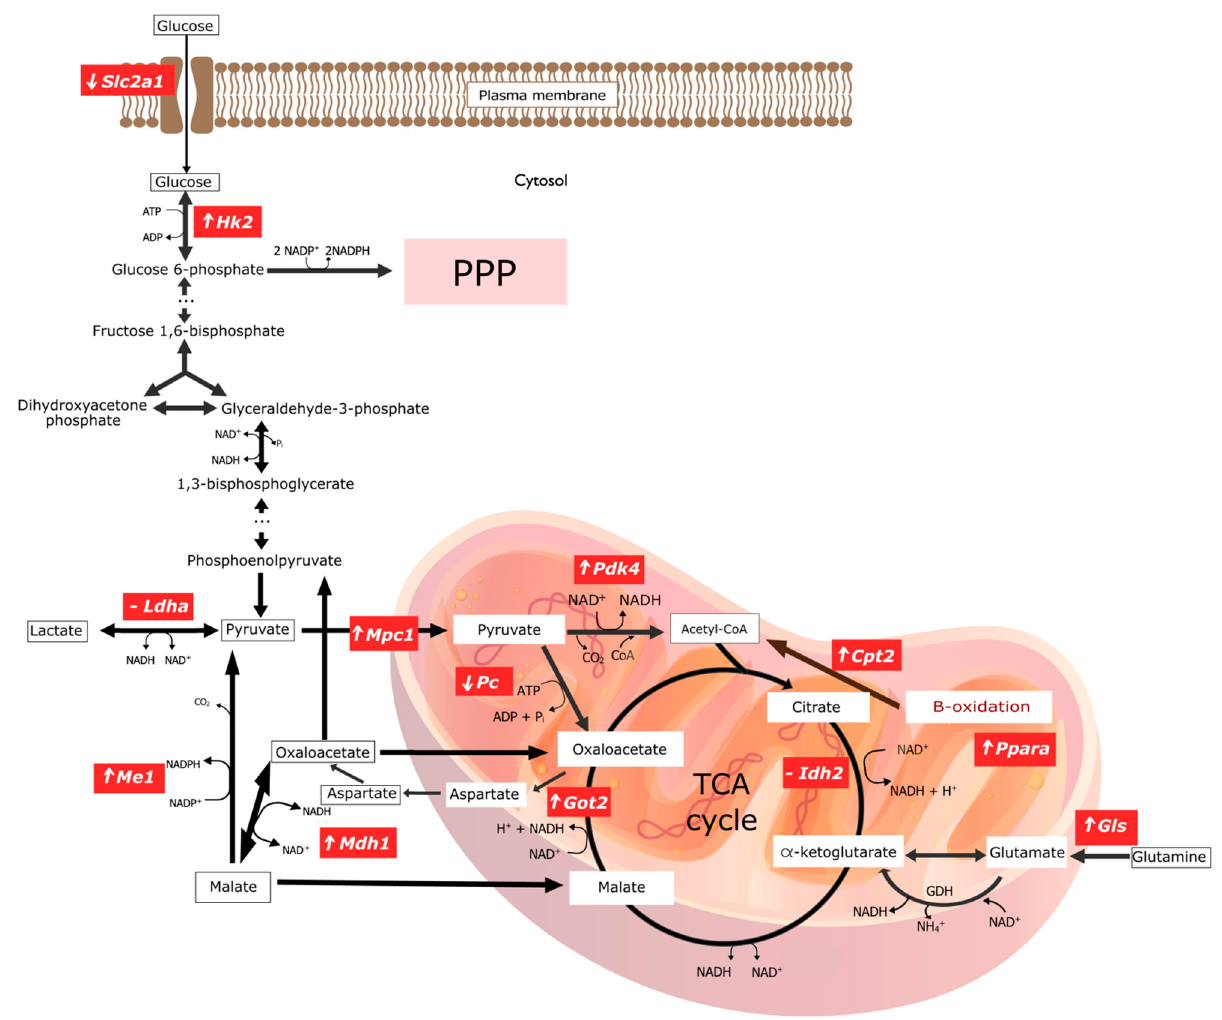
Figure 2. Graphical representation of changes in gene expression encoding key enzymes involved in selected pathways of energy transformations in experimental group of rats with copper deficiency. ‘ ⬆ ’ indicates overexpression of the gene encoding the given enzyme; ‘ ⬇ ’ indicates a down- expression of the gene encoding the given enzyme; ‘-‘ means there are no significant statistical changes. The graphic was made in the open-source vector graphics editor InkScape. ADP, Adeno- sine diphosphate; ATP, Adenosine triphosphate; CO 2 , Carbon dioxide; CoA, Coenzyme A; Cpt2 ,